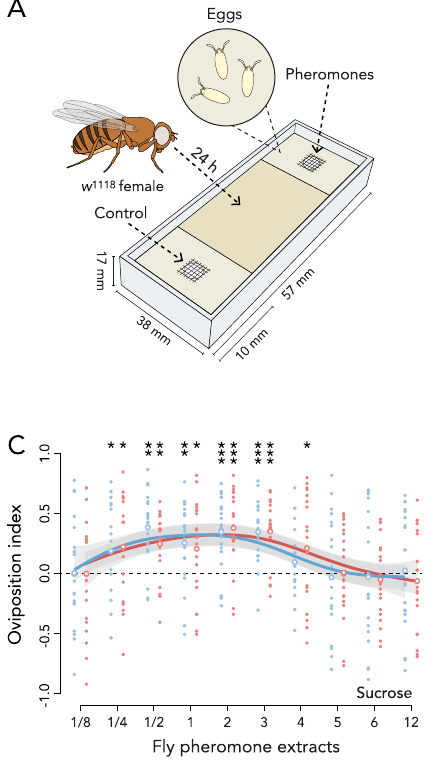
Fig. 1 | Pheromones affect communal oviposition site selection in a non-linear dose dependent manner. A Overview of the two-choice oviposition assay. The female can lay eggs in oviposition zones of 0.75% agar at either end of the assay (light zones). Both oviposition zones enclose a mesh covered cup containing the pheromones or solvent control treatments. These two oviposition zones are separated by a zone of 3% agar unsuitable for oviposition (dark zone). After 24h, eggsarecountedandanovipositionindexiscalculated:(Eggsside1 − Eggsside2)/ (Eggsside1+Eggsside2). B Cuticularpheromoneextractsofsingle w 1118 maleskept in groupsof 1, 2,6 or12males (yellow)and the totalconcentration of pheromones deposited by these groups of w 1118 males (turquoise). The concentrations were compared using a GLMand the error bars indicate the standarderror of the mean. The line and P -value above the plotted lines represents the analysis of the single male extracts and the line and P -value below the plotted lines represents the ana- lysisofthedepositsmadebygroupedmales.TableS1reportsthetotalpheromone concentrations and that of individual compounds ( n =9 for 1 fl y, n =8 for 2 fl ies,